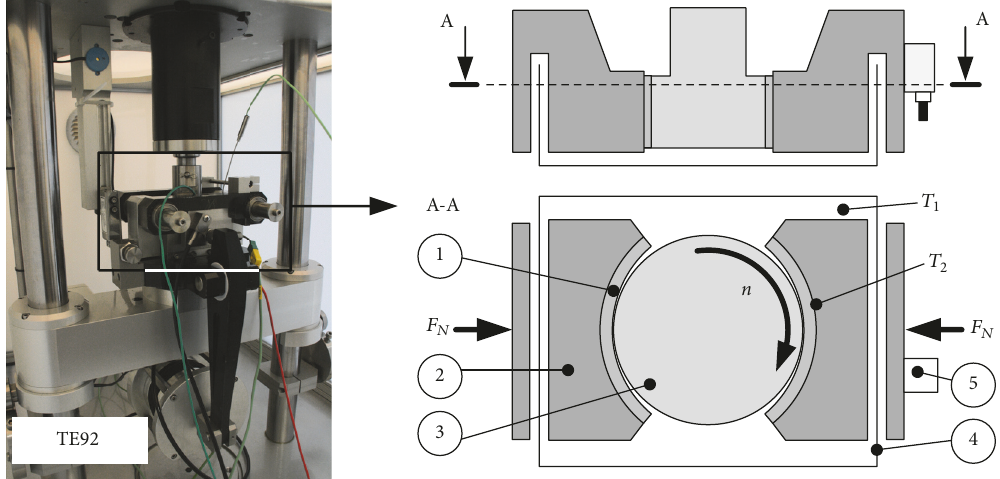
Figure 3: Journal Bearing Adapter (JBA) and a schematic representation of the test cell. (1) 120 ∘ journal bearing shells, (2) specimen holder, (3) shaft specimen, (4) oil bath, and (5) AE